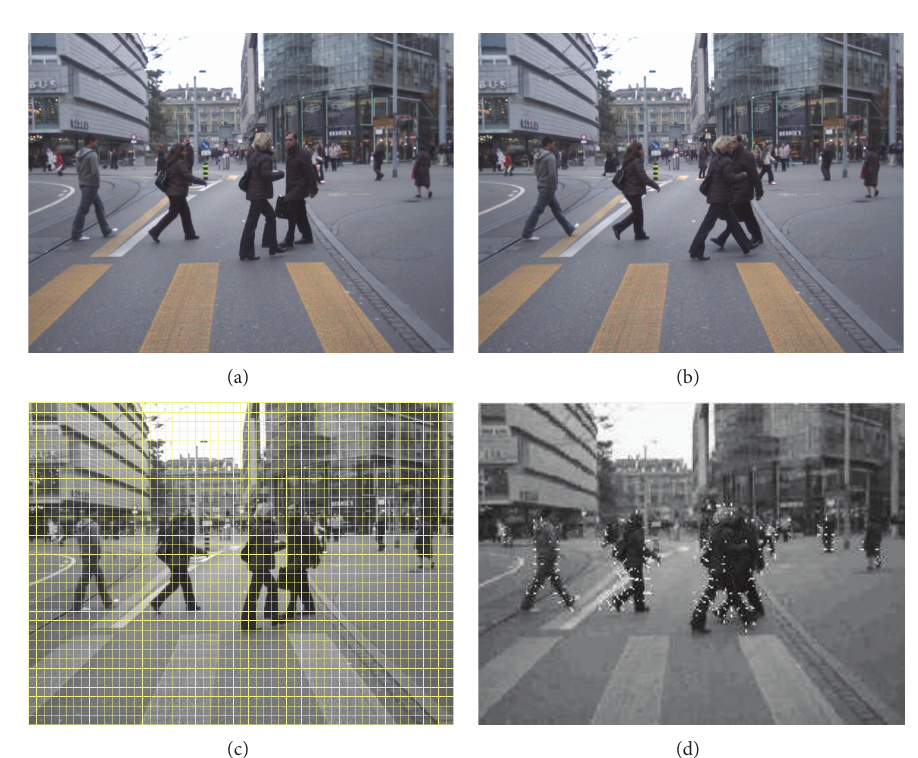
Figure 2: From two consecutive image sequences (a) and (b), we decide grid windows (c) and track each window in the next consecutive image